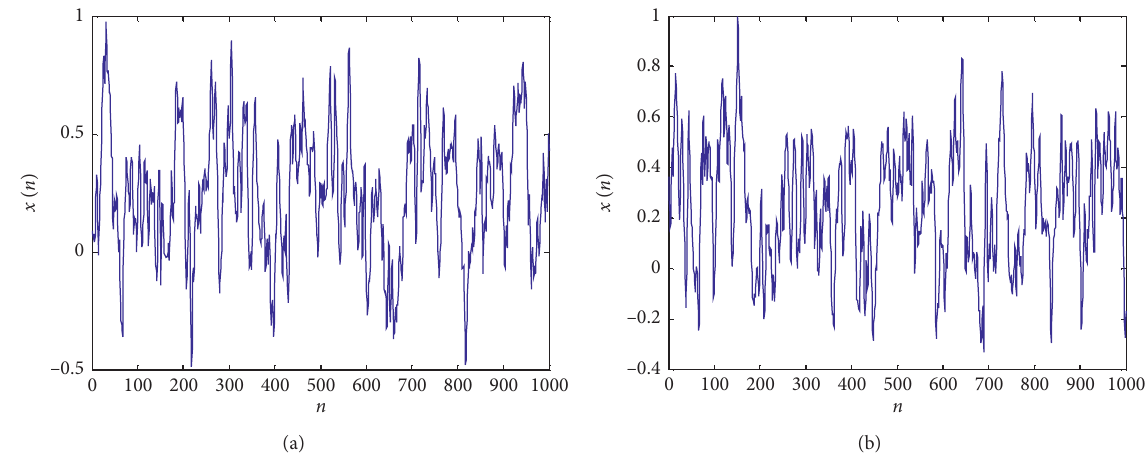
Figure 7: (a) Underwater acoustic signal data set A; (b) underwater acoustic signal data set B.